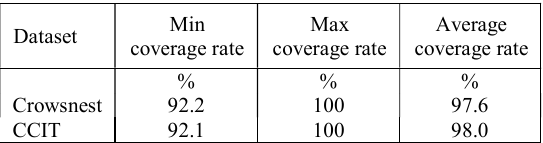
Table 5. Coverage tests of 100 random cases